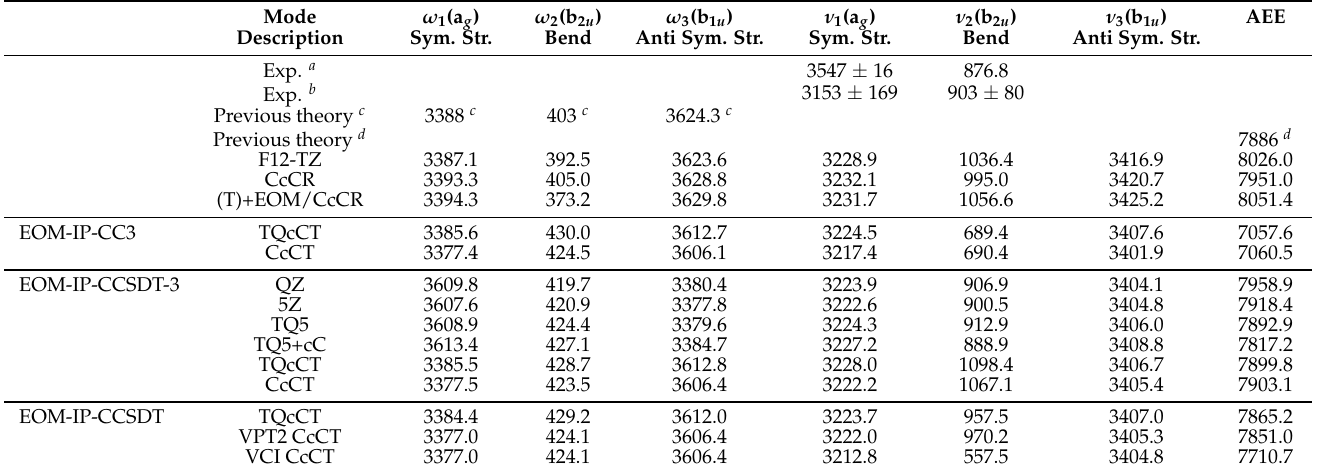
Table 6. Ã 2 A 1 H 2 O + Vibrational Frequencies in cm − 1